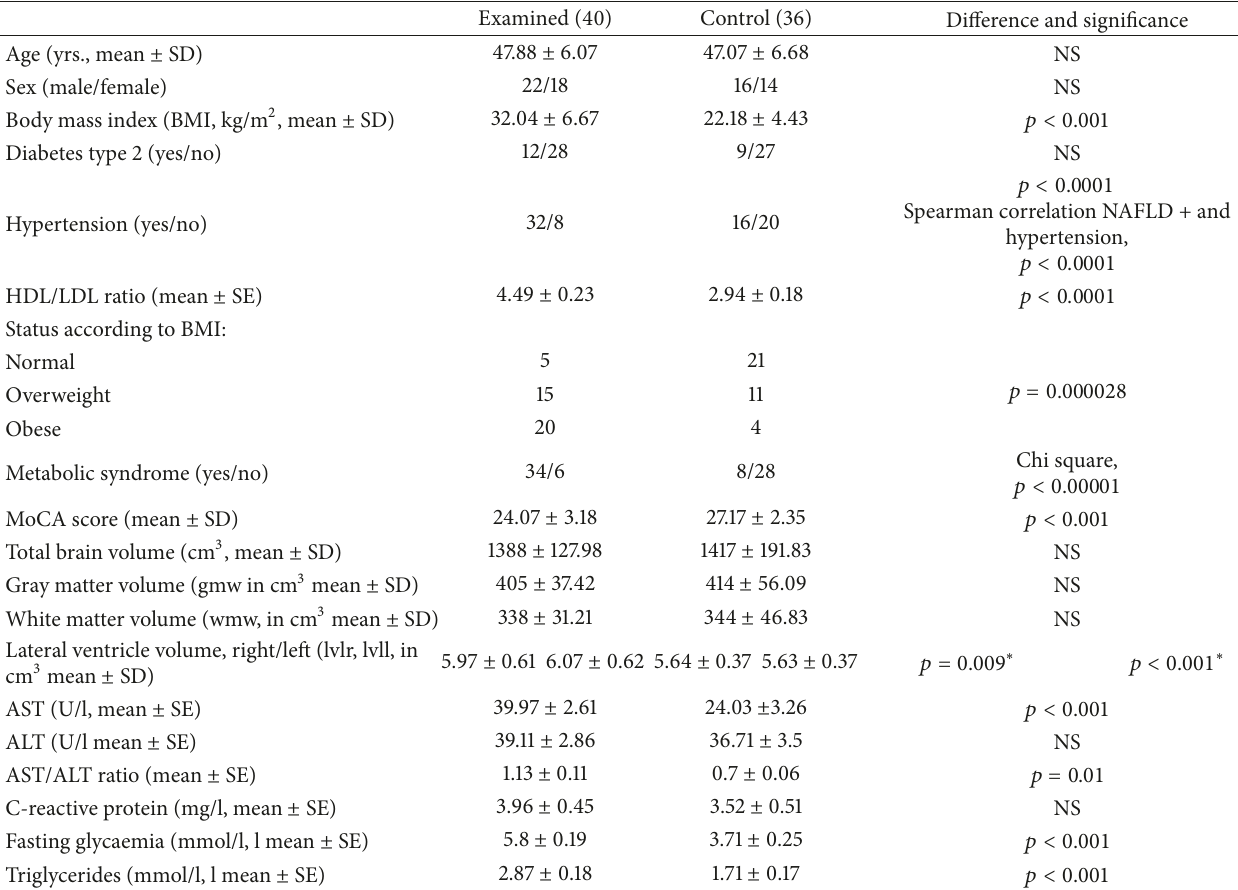
Table 1: Demographic characteristics of examined